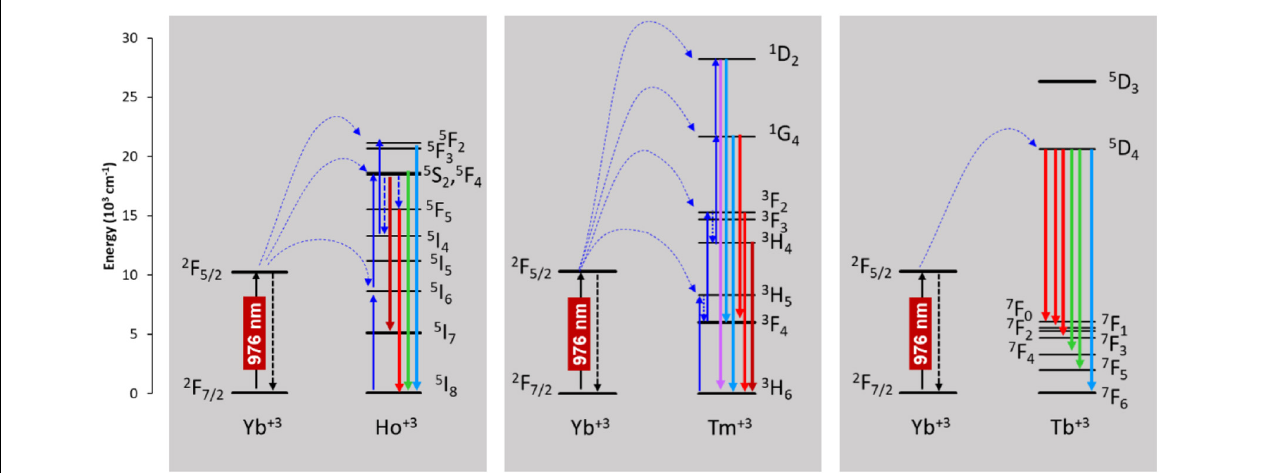
FIGURE 5 | Energy level diagrams of the active ions responsible for the upconversion photoluminescence.